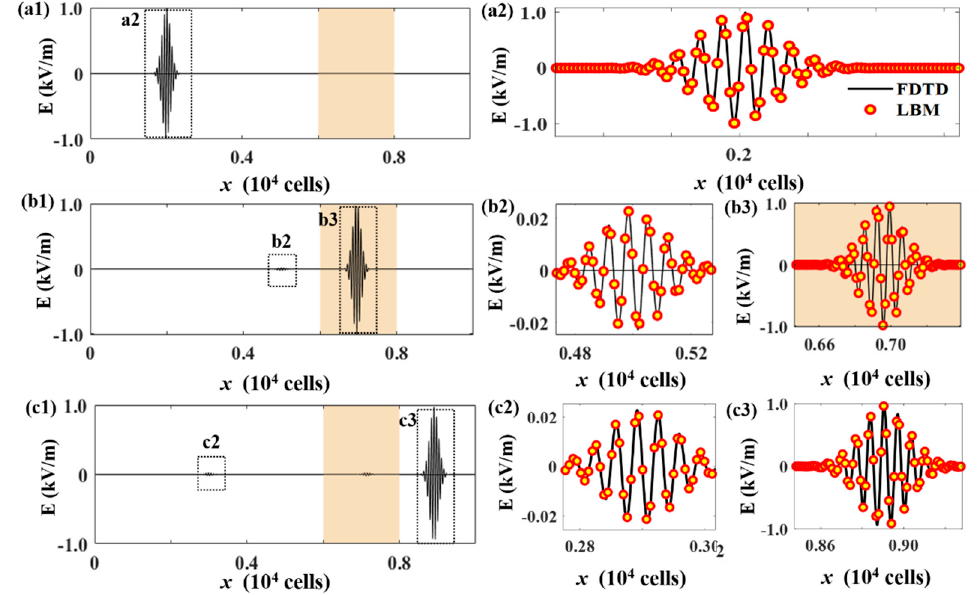
Figure 6. Simulation of a wave propagating in air and striking a plasma medium. The plasma has the properties of silver: ω p = 2000 THz, ϑ c = 50 THz. The propagating wave has a center frequency of 4000 THz. ( a , b ) show electric field in the computational domain at different times ( a ) = 0 fs, ( b ) = 17 fs, and ( c ) = 23 fs. (Left side with film thickness of 1000 cells, right side with film thickness of 2000 cells).